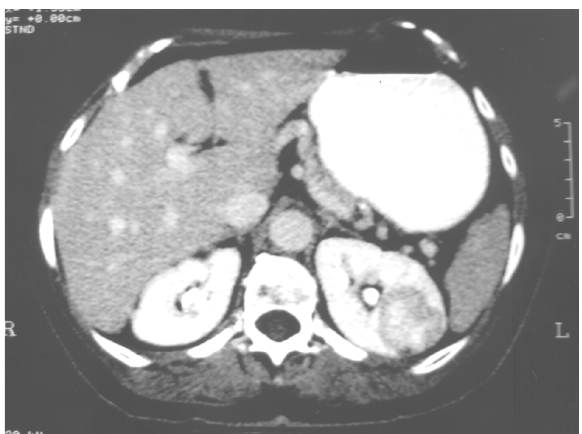
Figure 2 – Computed tomography scan of the abdomen (axial view) shows a solid, approximately 4 cm, left renal mass, appar- ently restrict to renal